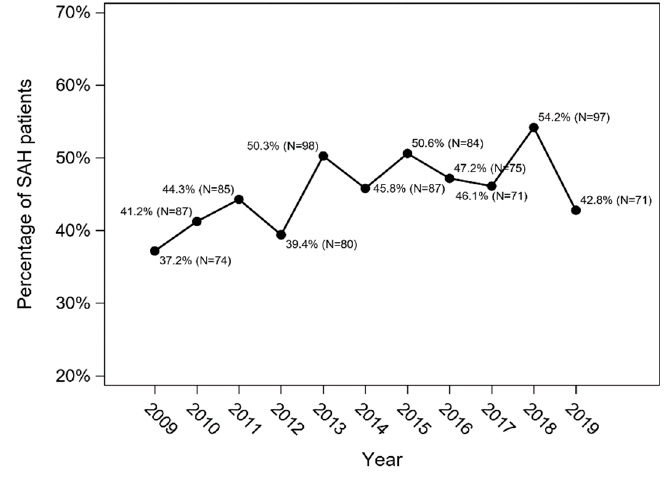
Figure 8. Overall combined mortality (in-hospital mortality and post-discharge 12-month mortality)